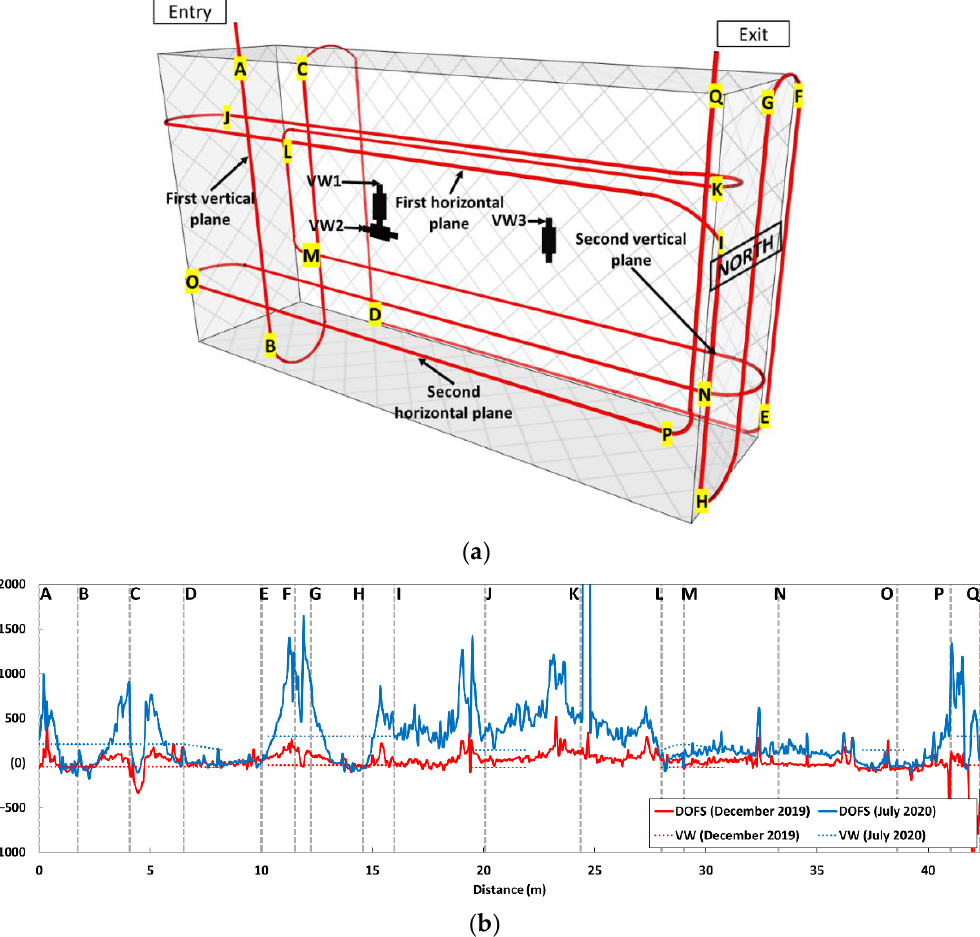
Figure 15. ( a ) Instrumentation scheme of the block KB with embedded DOFS, in which segments of the DOFS path are identified with alphabet letters; ( b ) Strain profiles along the DOFS (in solid lines) together with VW measurements (dotted lines).